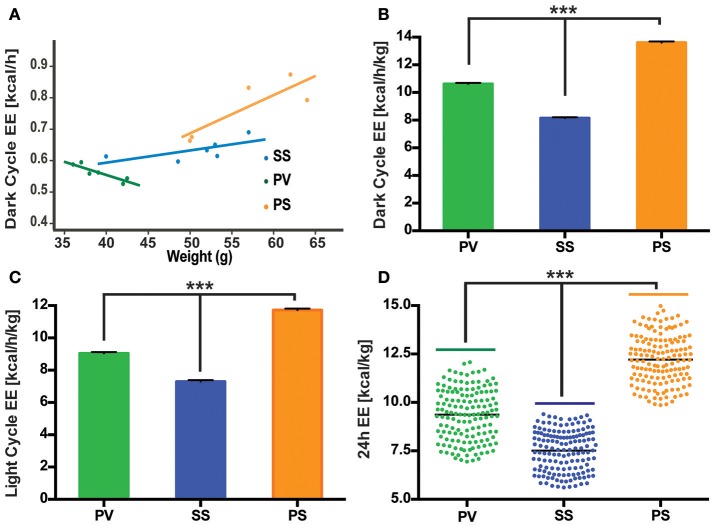
Bilateral subdiaphragmatic vagotomy influences EE in fully obese Mc4r−/− mice. (A) Graph showing the relationship of EE (expressed in kcal/h) to body mass (n = 4–5 per treatment group). Data are presented as a linear regression plot. (B,C) Graphs showing mean EE (expressed in kcal/h/kg; n = 5–7 per treatment group) in dark and light cycles, respectively. (D) Vertical dot plot of 24 h EE data expressed as kcal/kg with mean (black bar). ***p < 0.001 criterion for statistical significance.